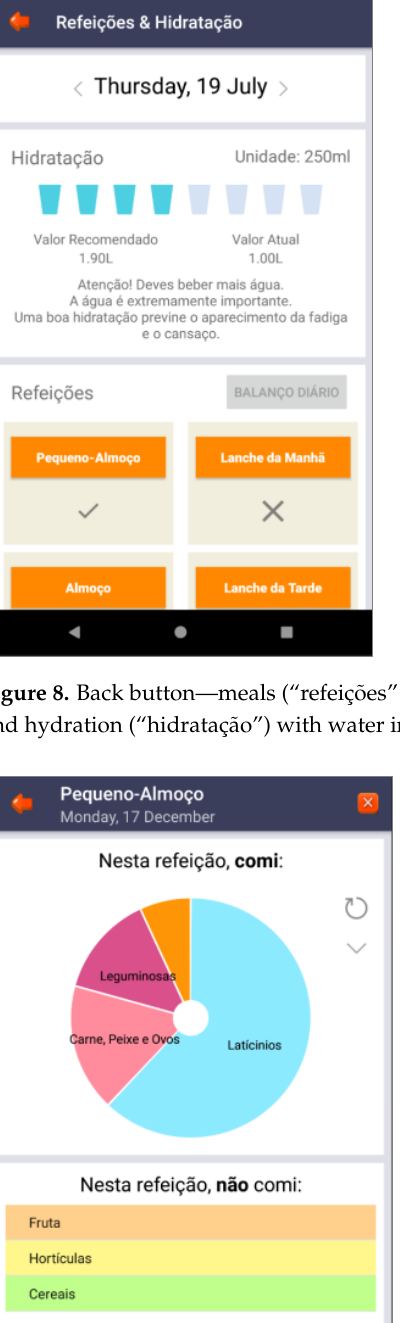
Figure 10. Back button —biomedical data (“dados biométricos”) w ith body mass index (BMI – “índice de massa corporal (IMC)), waist circumference (“perímetro da cintura”)— mental model. The strategy presented in Table 1 shows how game elements [56] in mobile apps could be used to define health procedures. In this particular case, the design team applied the universal principles of design [55] justifying their decisions. These principles follow visual examples of concepts applied in practice. The web back office application prototype was also validated in the same session by two experts (a health professional and a teacher), allowing us to elicit additional func- tional requirements not previously considered. However, due to the sample size being so reduced ( n = 2), the results were considered not significant, and we decided to not include them here.